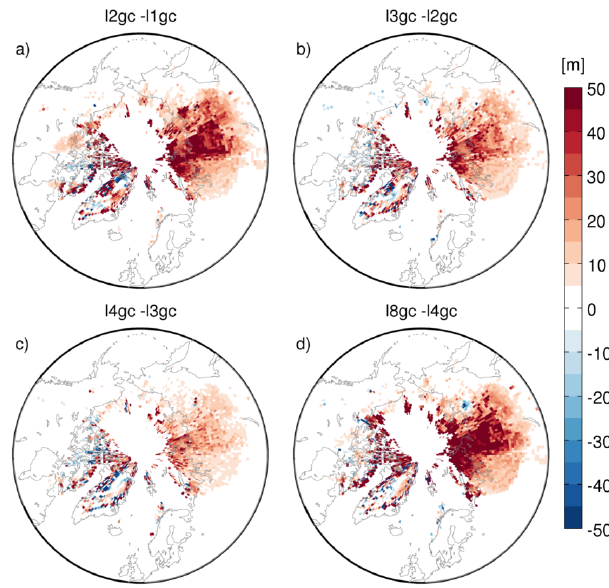
Figure 18. Present-day permafrost thickness differences between model runs started during different interglacial periods as indicated over each